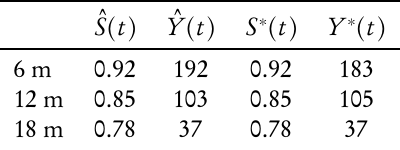
Survival probabilities ( ˆ S ( t ) ) and numbers at risk( ˆ Y ( t ) ) reported by Rajkumar et al. (2010) and mean survival probabilities (S ∗ ( t ) ) and numbers at risk(Y ∗ ( t ) ) form 10 4 simulations.